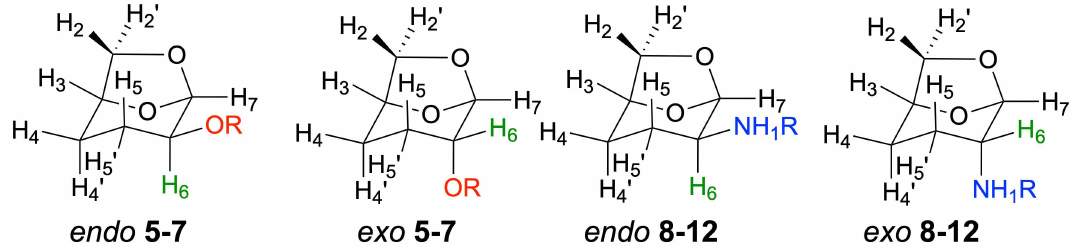
Figure 2. Depiction of the endo and exo configurations as well as of the numbering scheme